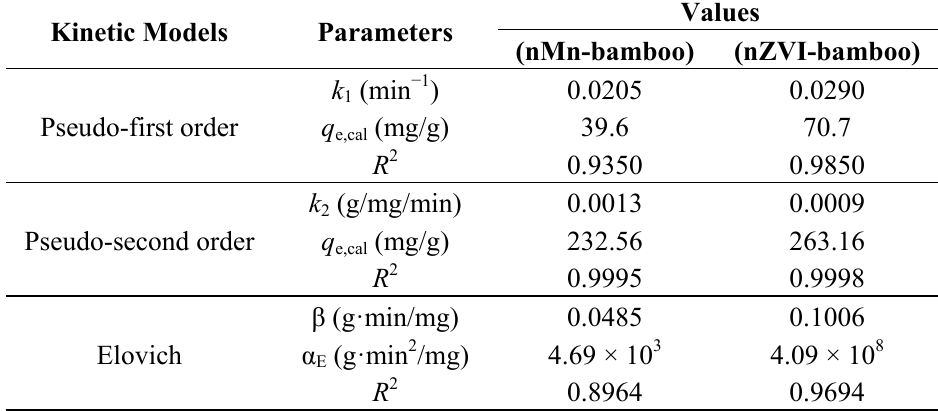
Table 5. Parameters and correlation coefficients of the kinetic models for nMn-bamboo and nZVI-bamboo